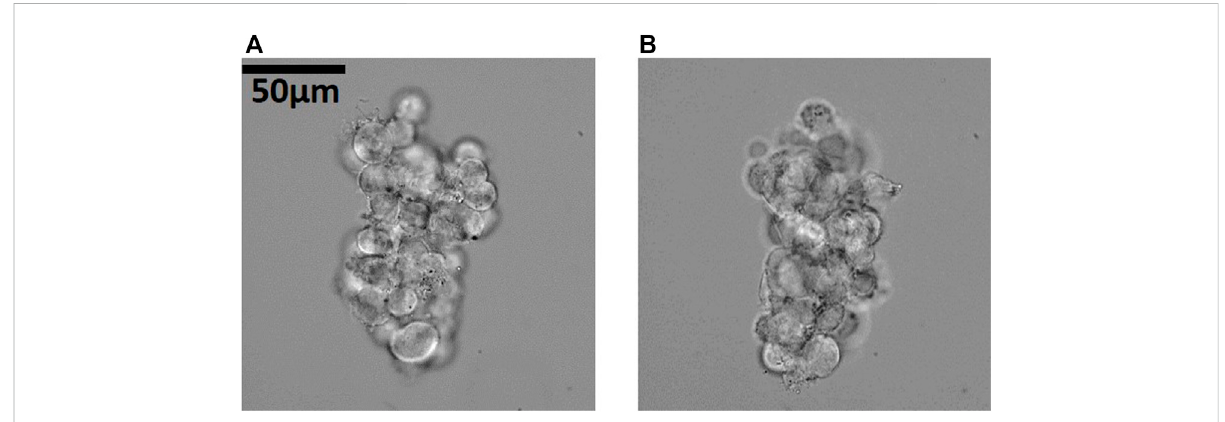
FIGURE 8 Reorientation of cell cluster for angle-scanning of the illumination in the high-NA compatible chip. Reorienting the sample to a new stable trapping orientation allows us to repeat illumination scanning at a different viewing direction, to improve the reconstruction. In (A) the cancer cell spheroid is trapped and oriented to a strong top-transducer, in (B) to a stronger x-transducer. NA con = 0.2. Corresponding Supplementary Movies S11,